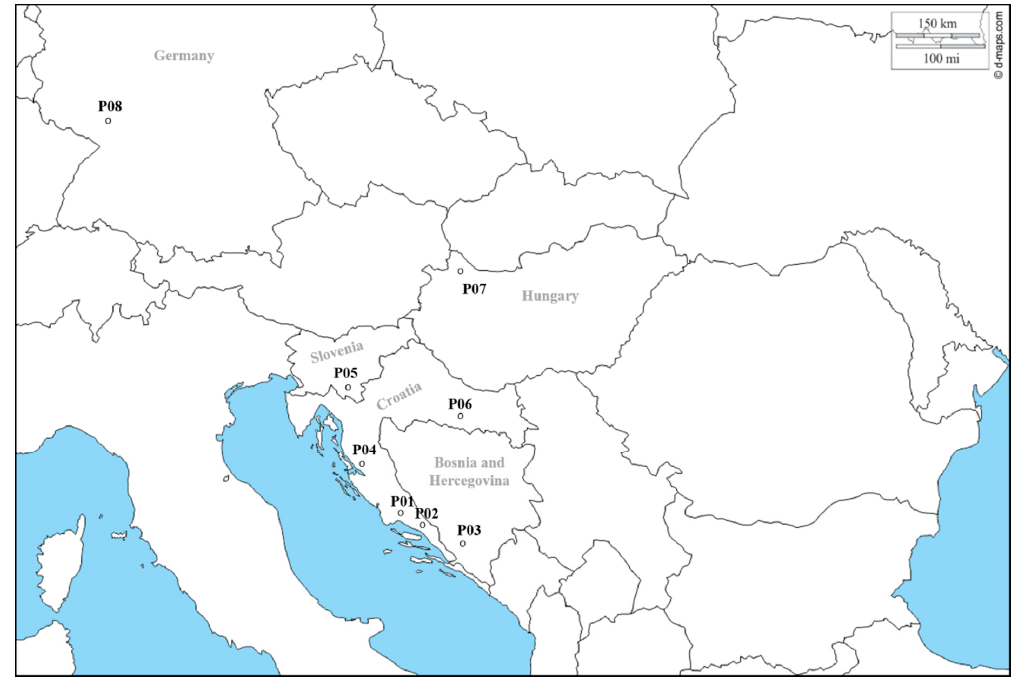
Figure 1. Geographic distribution of the eight sampled V. v. subsp. sylvestris populations.